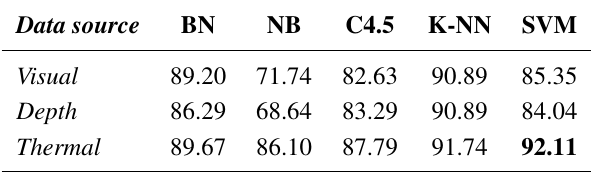
Table 2. 10-fold cross-validation accuracy percentage obtained for each classifier using